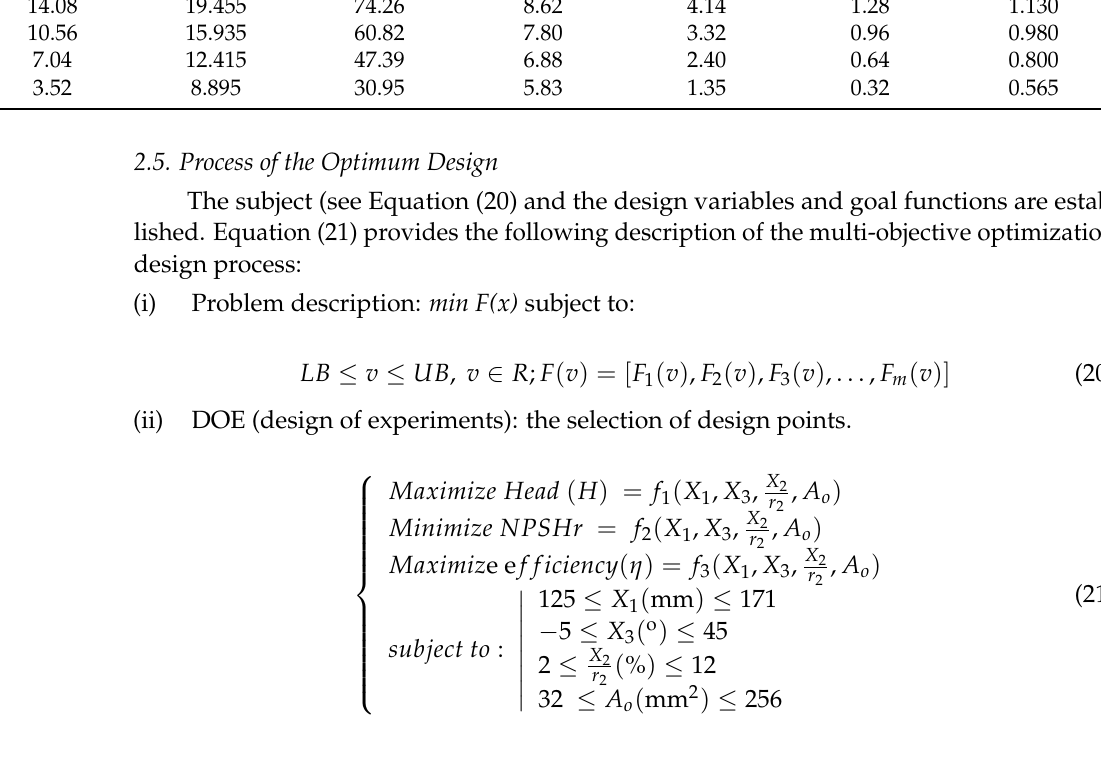
DOE (design of experiments): the selection of design points.